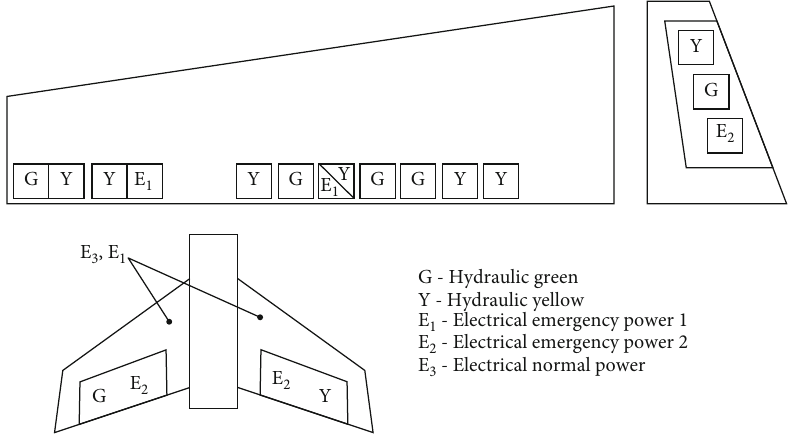
Figure 6: Aircraft main control